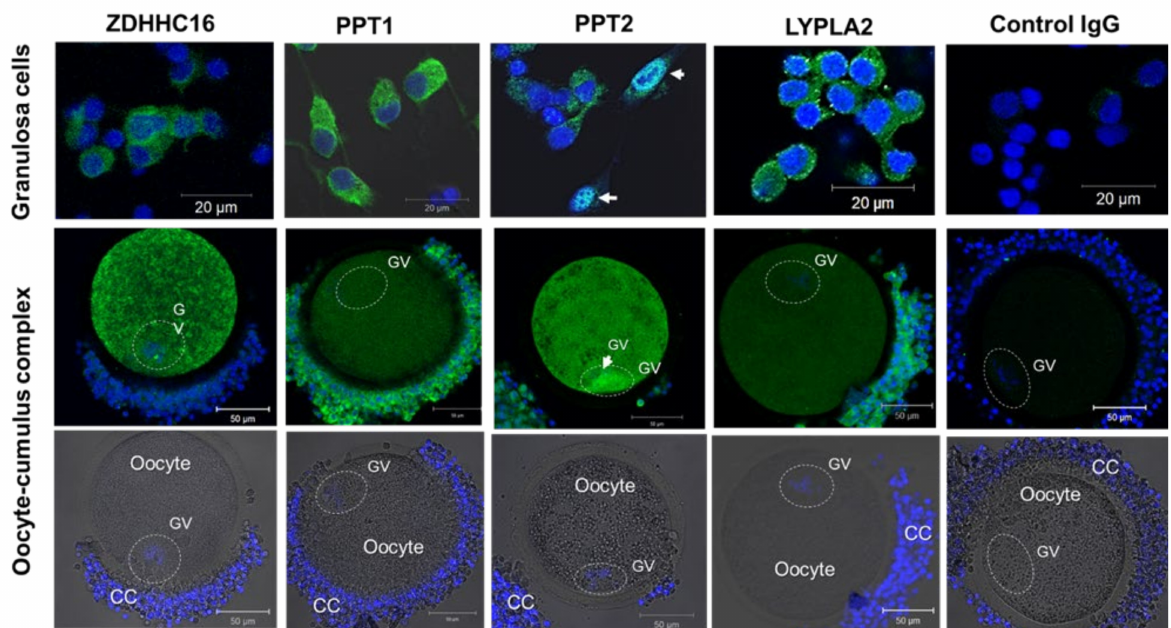
Figure 7. Immunofluorescence detection of protein acyl-transferase ZDHHC16, palmitoyl-protein thioesterases PPT1 (CLN1) and PPT2, and acyl-protein thioesterase LYPLA2 by confocal microscopy in bovine granulosa cells and cumulus-oocyte complexes treated with specific primary and fluorochrome-coupled secondary antibodies. For the control, rabbit and mouse IgG was used instead of primary antibodies. Specific IF labelling is shown in green. Hoechst33342 marks nuclear chromatin in blue. The position of germinal vesicle (GV) is marked with dotted line ovals. Arrows indicate nucleus with PPT2